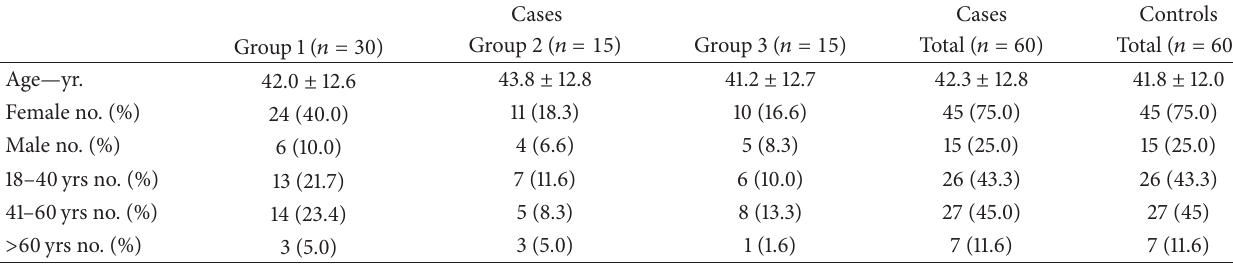
Table 1: Demographic characteristics of the participants.